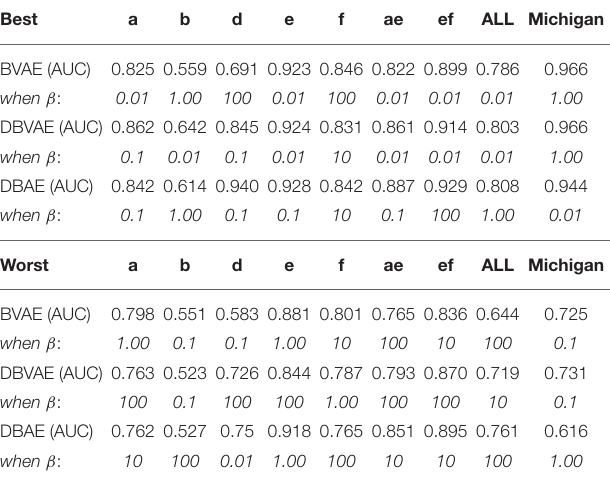
TABLE 1 | Best and worst performed system for all tests in terms of AUC values (at the first line of each row).